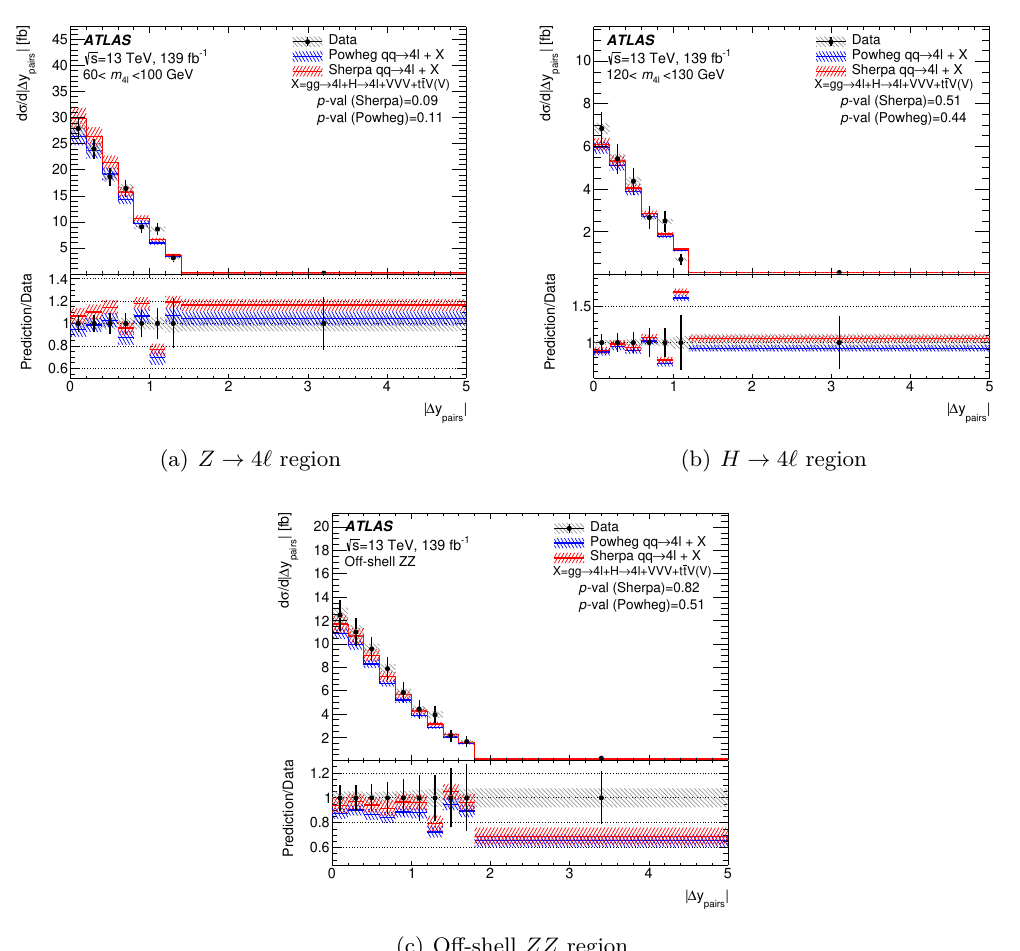
Figure 20 . Differential cross-section as a function of | ∆ y pairs | in m 4 ‘ regions. The measured data (black points) are compared with the SM prediction using either Sherpa (red, with red hashed band for the uncertainty) or Powheg + Pythia8 (blue, with blue hashed band for the uncertainty) to model the q ¯ q → 4 ‘ contribution. The error bars on the data points give the total uncertainty and the grey hashed band gives the systematic uncertainty. The p -value is the probability for the χ 2 , with the number of degrees of freedom equal to the number of bins in the distribution, to have at least the observed value, given the SM prediction. The lower panel shows the ratio of the SM predictions to the